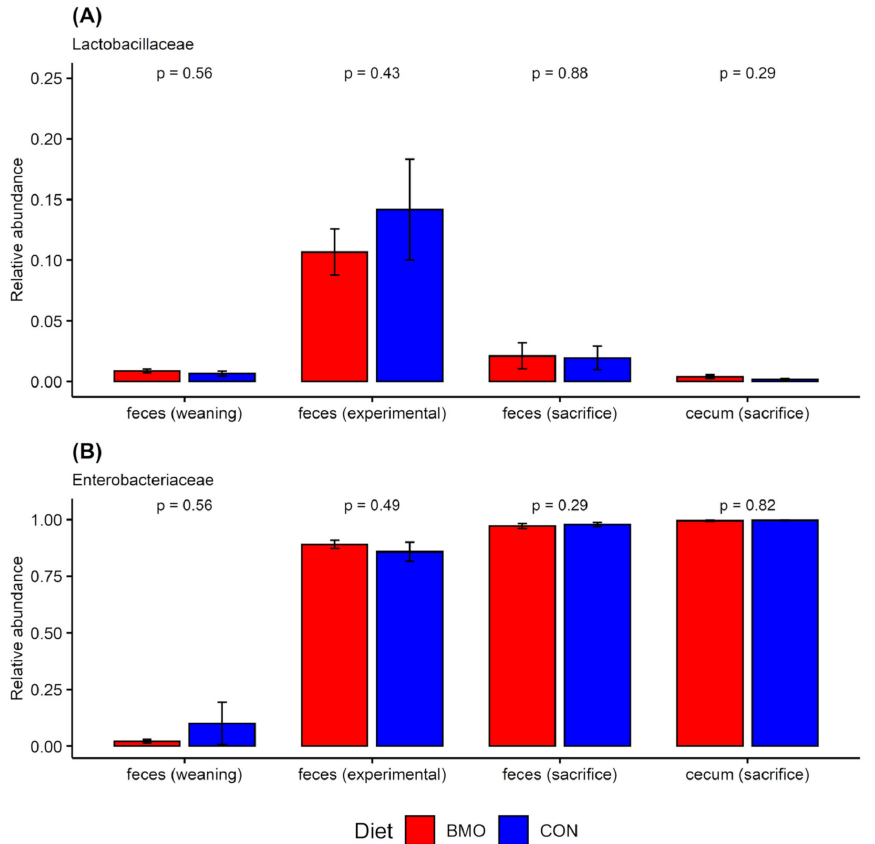
Figure 6. Relative abundance of selected families in samples collected throughout the study. ( A ) Lac- tobacilliaceae, ( B ) Enterobacilliaceae. The x-labels indicate the sample type and time of collection: feces (weaning): feces collected during weaning (BMO n = 5, CON n = 4), feces (experimental): feces collected midway through the experimental period (BMO n = 10, CON n = 6), feces (sacrifice): feces collected before sacrifice (BMO n = 11, CON n = 9), cecum (sacrifice): cecum content collected after sacrifice (BMO n = 11, CON n = 9). Colors indicate the dietary treatment: BMO: synthetic diet with 2% bovine milk oligosaccharide, CON: control diet with lactose. Dots show individual samples, bars are mean values and error bars show standard error. p -values above bars are t -test comparing the average relative abundance in samples from the two diets collected at the same time